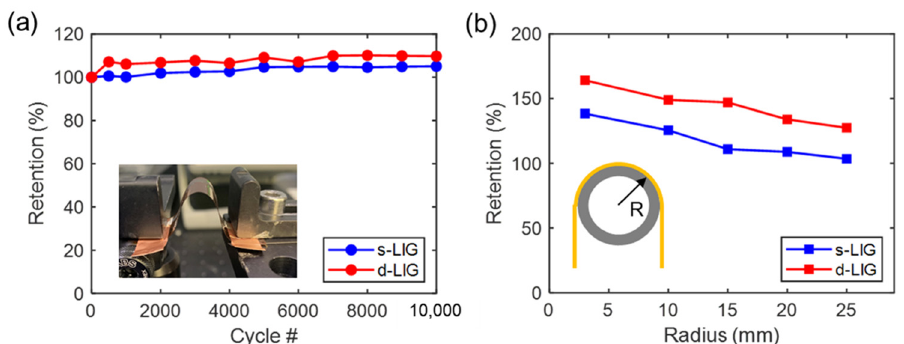
Figure 4. Resistance-based flexibility of bent d-LIG and s-LIG electrode strips. Retention of resistance (%) ( a ) after up to 10,000 cyclic bending events, with inset showing a photograph of bending test setup with bent LIG strip, and ( b ) under bending conditions with different bending radii (a parameter that is defined schematically in the inset).